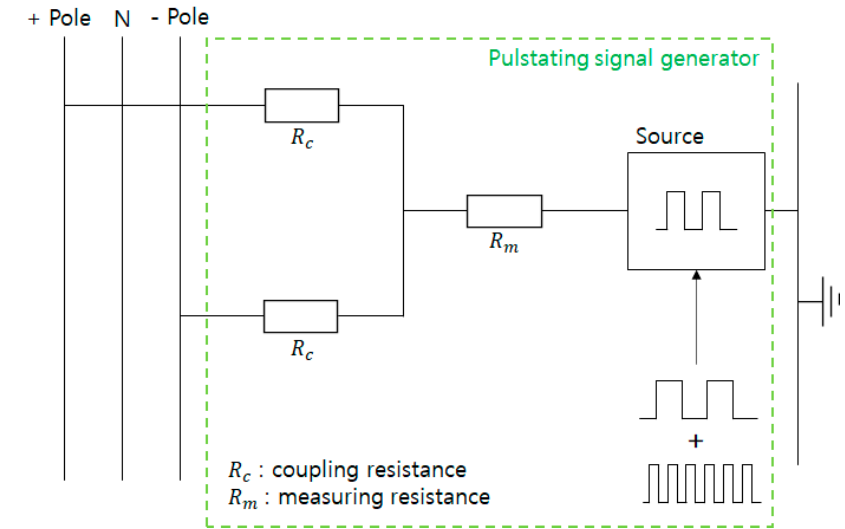
Figure 5. Schematic diagram by power systems computer-aided design (PSCAD) modeling of the pulsating signal generator.